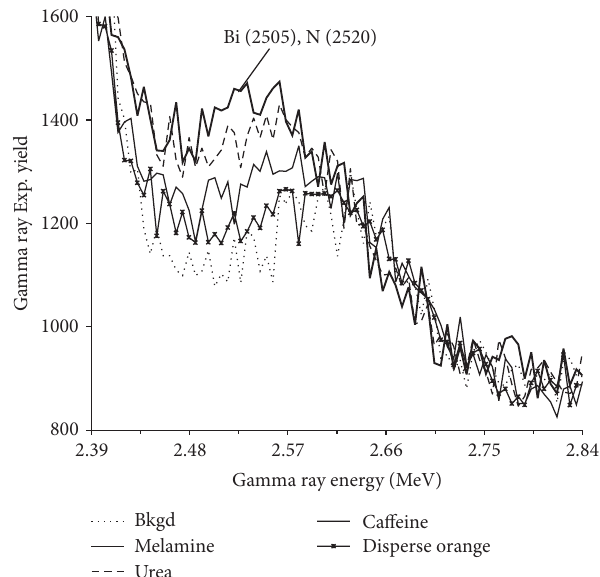
Figure 8: Enlarged unresolved 2.50 and 2.52 MeV bismuth and nitrogen prompt gamma ray experimental pulse height spectra of BGO detector from caffeine, disperse orange, melamine, and urea samples over 2.39–2.84 MeV.